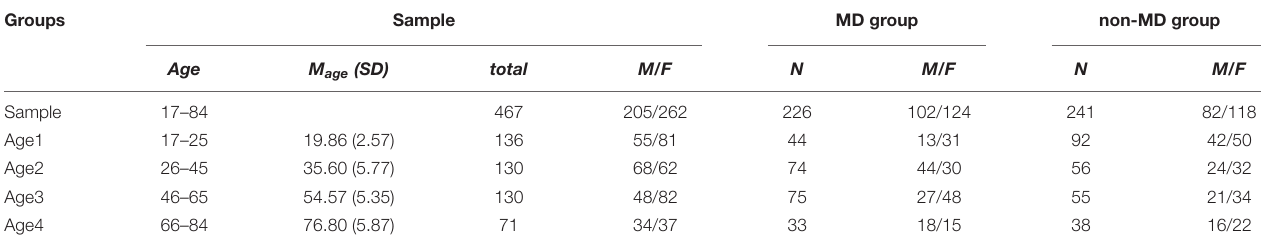
TABLE 1 | Information about the sample and the groups of the study. Groups Sample MD group non-MD group